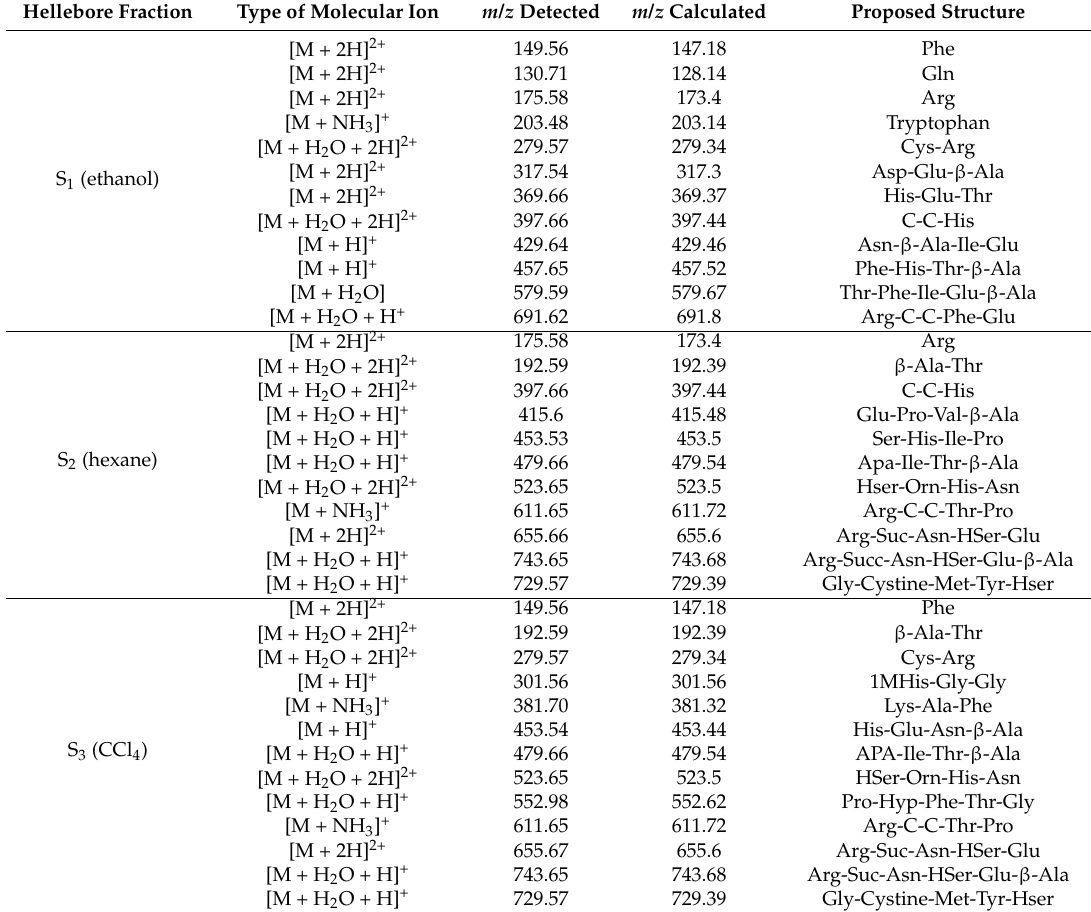
Figure 9. Positive ion mode nano-ESI-Chip-MS of the hellebore thionins in acetone fraction. Table 4. Amino acids and peptides species in hellebore fractions detected by MS.